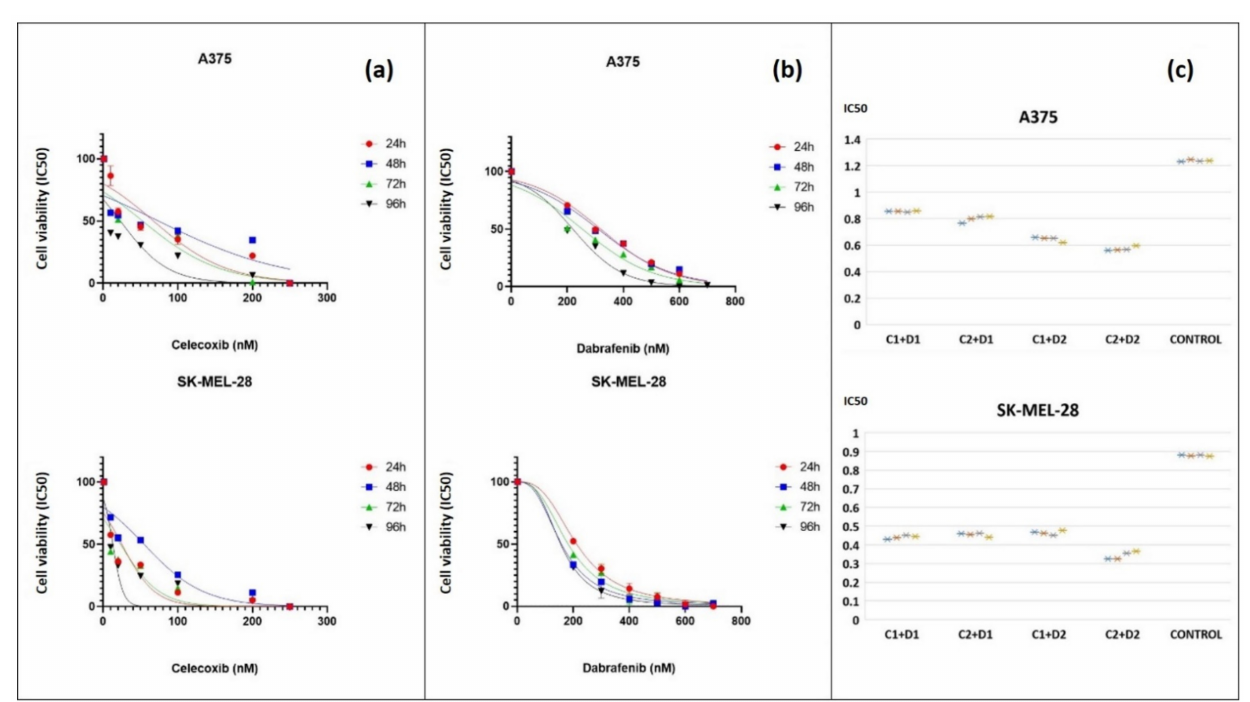
Figure 1. Cell viability analysis after exposure to celecoxib and dabrafenib. Experiments started with A375 and SK-MEL-28 melanoma cell lines exposed for 24, 48, 72, and 96 h to different concentrations of celecoxib ( a ) and dabrafenib ( b ). Following these viability tests two concentrations were selected for celecoxib (C1 = 50 nM, C2 = 100 nM) and dabrafenib (D1 = 100 nM, D2 = 200 nM) to be evaluated as a novel drug combination for 72 h ( c ). The first two IC 50 graphs ( a , b ) were obtained using GraphPad Software, Nonlinear regression (curve fit) and show mean and error values ± standard deviation (SD), n = 3 for each sample. The third panel ( c ) illustrates cell viability analysis after 72 h exposure to four drug combinations using Excel-Box and Whisker. Each drug combination was tested in quadruplicate ( n = 4) and was marked as asterisk (*) on the graph. Cell viability diminished with increasing concentrations of celecoxib and dabrafenib in a dose- and time-dependent manner. The suitable IC 50 doses were chosen for celecoxib (50 nM) (A375: IC 50 = 1.290 nM, R 2 = 0.8549; SK-MEL- 28: IC 50 = 0.9957 nM, R 2 = 0.9530) and dabrafenib (200 nM) (A375: IC 50 = 2.350 nM, R 2 = 0.9690; SK-MEL-28: IC 50 = 2.264 nM, R 2 = 0.9777) to be further used as a combination in